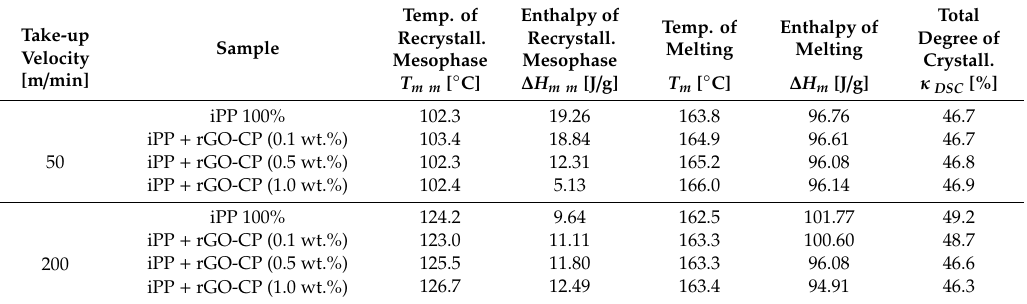
Table 4. Parameters determined on the basis of DSC measurements for fibers taken at 50 and 200 m / min. Take-up Velocity [m / min]